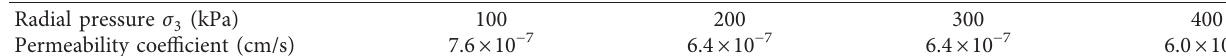
Table 4: Loess-lime (volume ratio: 3 :7) penetration test results.